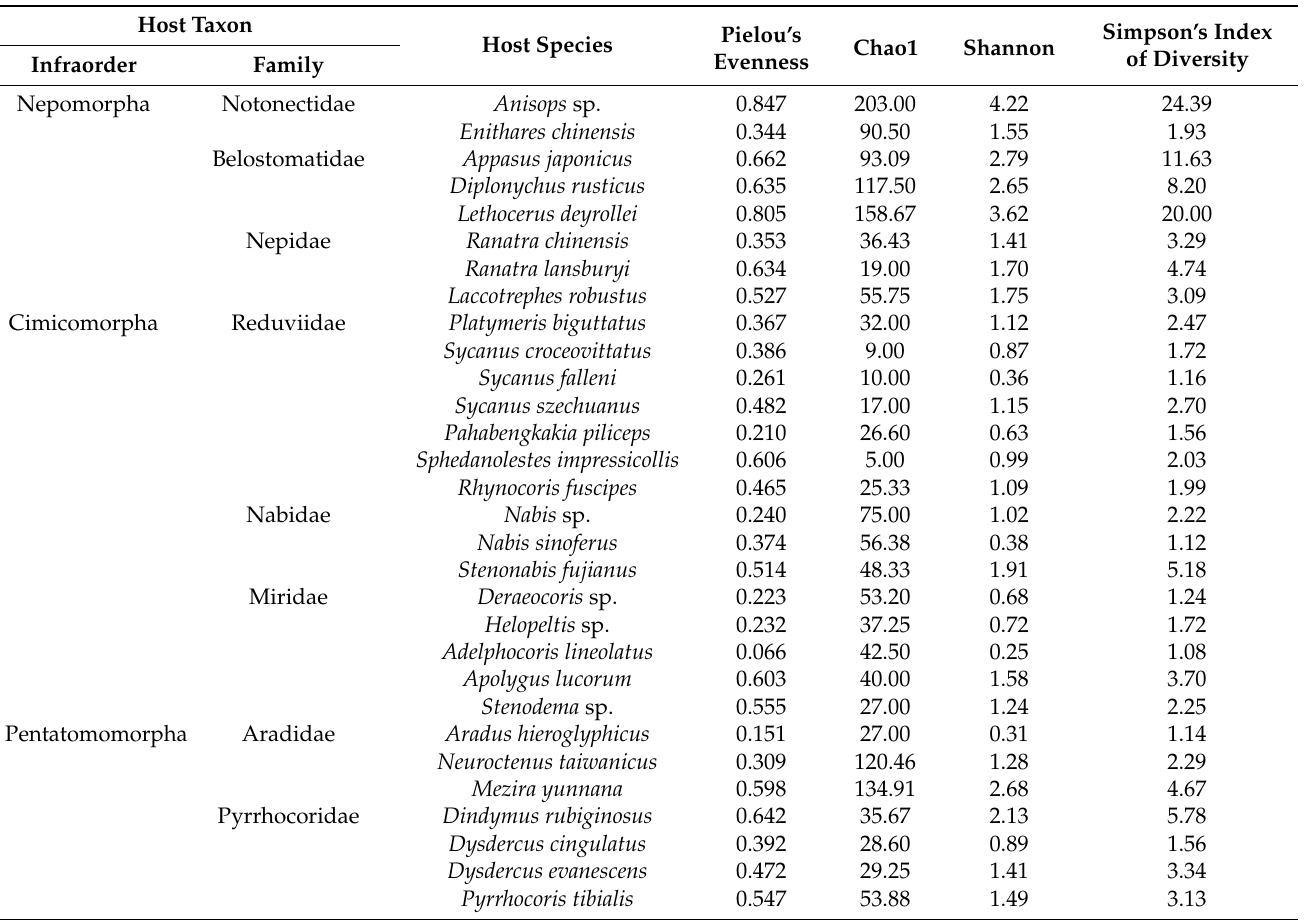
Table 1. Richness and diversity of the gut bacterial